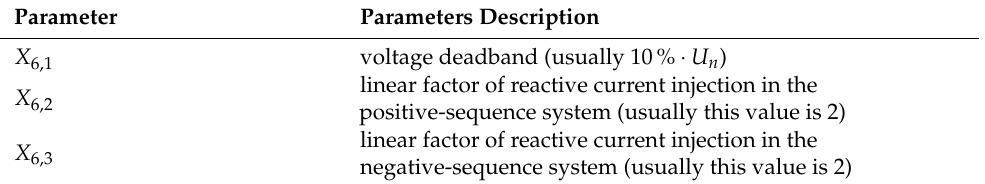
Table A4. Parameters X 6 of function F 6